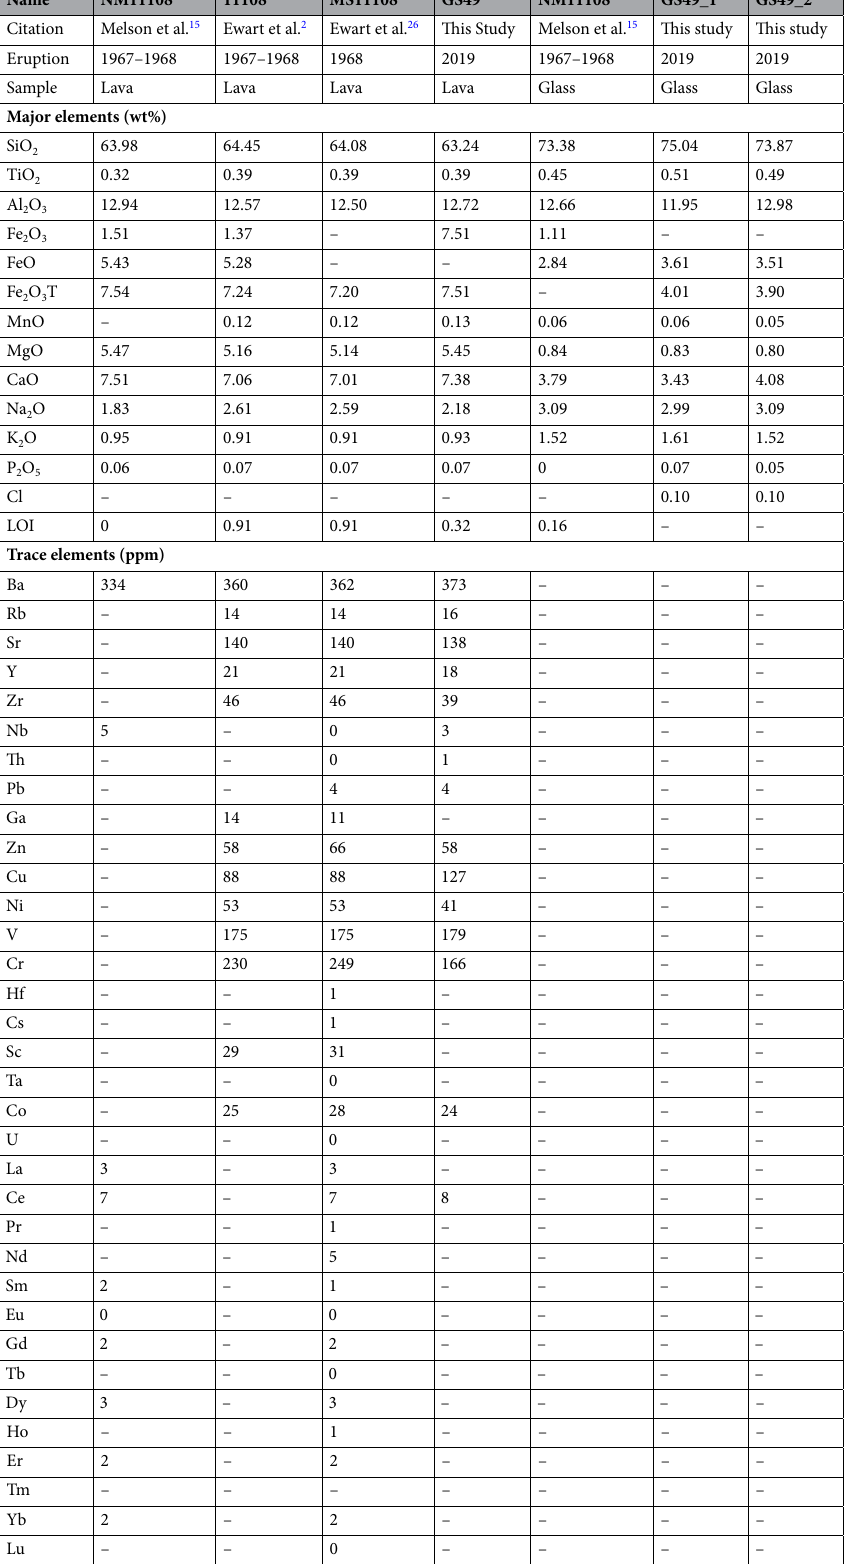
Table 1. Summary of whole-rock and glass chemical analyses for the 1967–1968 and 2019 eruptions from Late’iki. Whole-rock data normalised on an LOI-free basis. Data for the 1967–1968 eruption from Melson et al. 15 and Ewart et al. 2,27